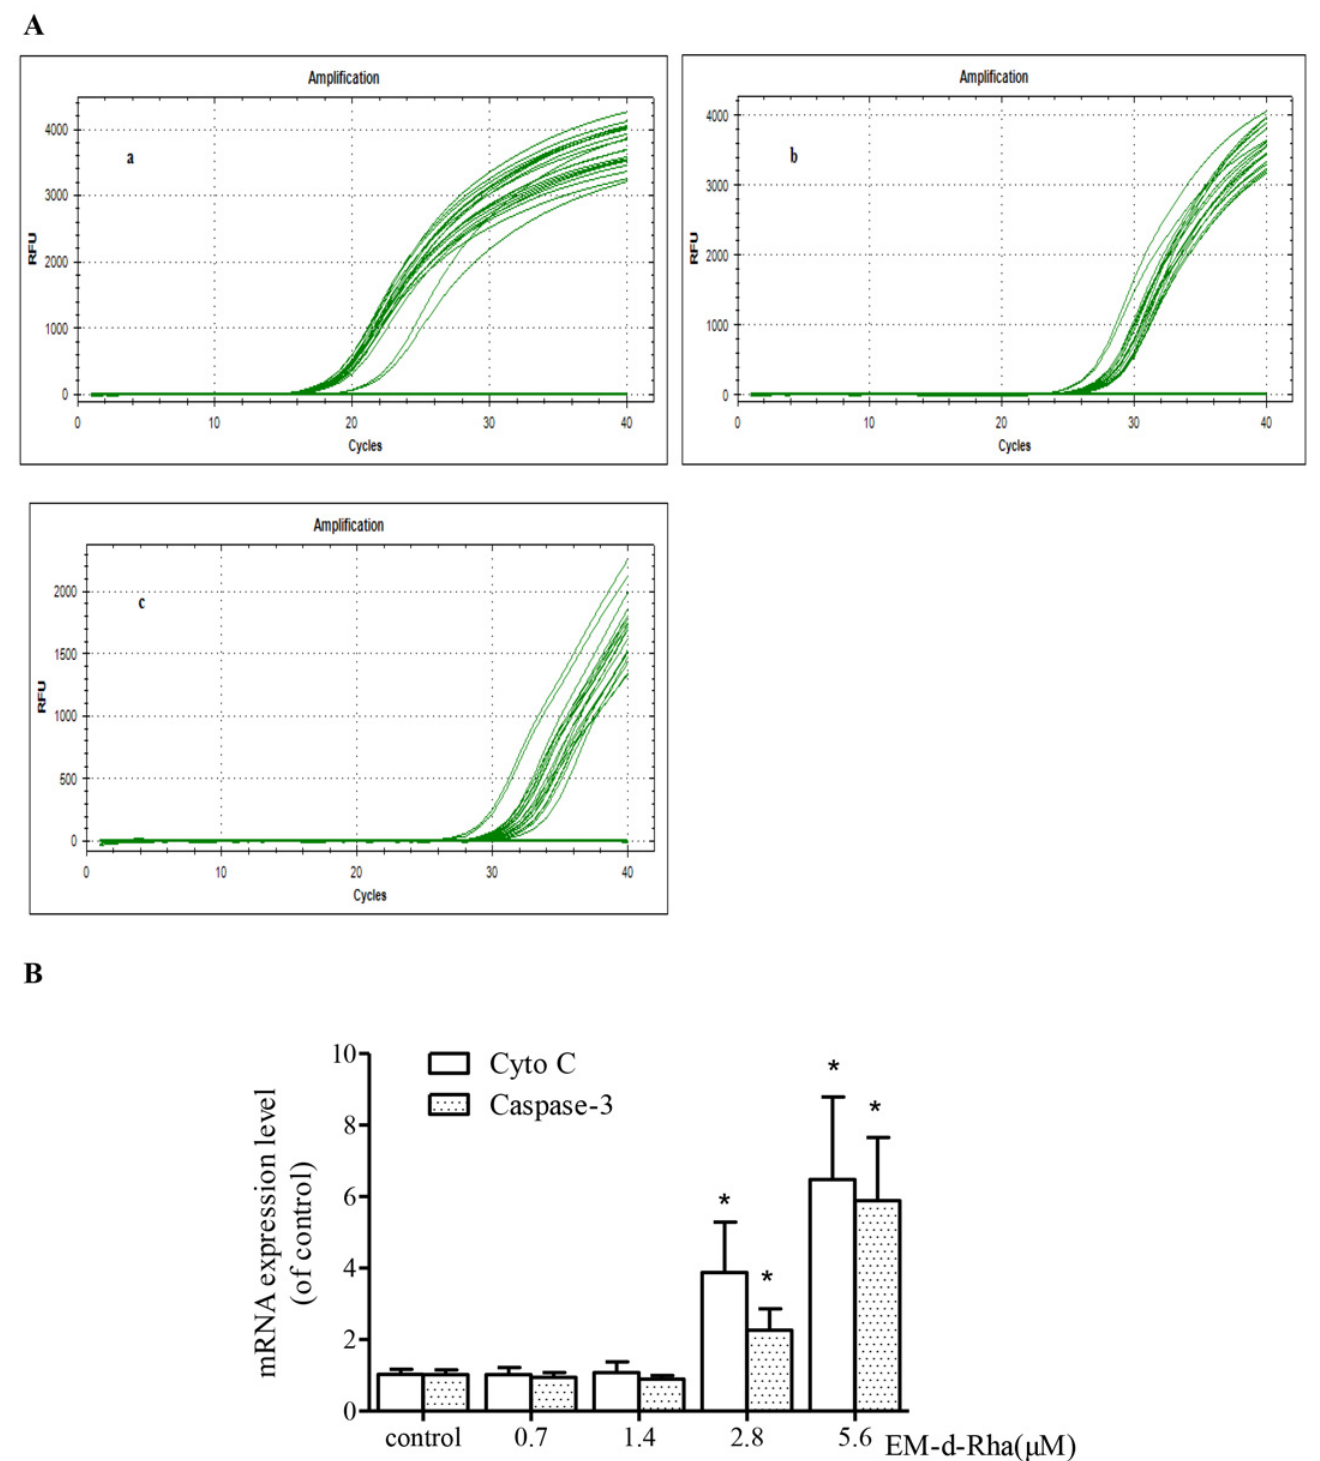
Fig 13. Effects of EM-d-Rha regulating the expression of Cytochrome C and Caspase-3. The gene expression levels of Cyto C and Caspase-3 were quantified by detecting the threshold cycle (CT) values with real-time quantitative PCR. A: Real time quantitative PCR amplification curve for different gene, a, b and c represents β -actin, cyto C and caspase-3, respectively.B: The mean fold change of cyto C and Caspase-3 expression is calculated by the 2 - Δ Δ CT method and expressed on each histogram. The values represent means ± S.E of four replicates experiments. Asterisk represents significantly different when compared to control ( p < 0 . 05 ).